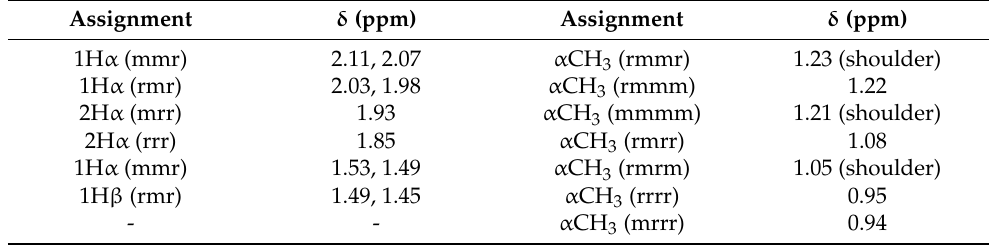
Table 1. 1 H NMR assignments characterizing the triads and tetrads in PMMA using CDCl 3 as the solvent